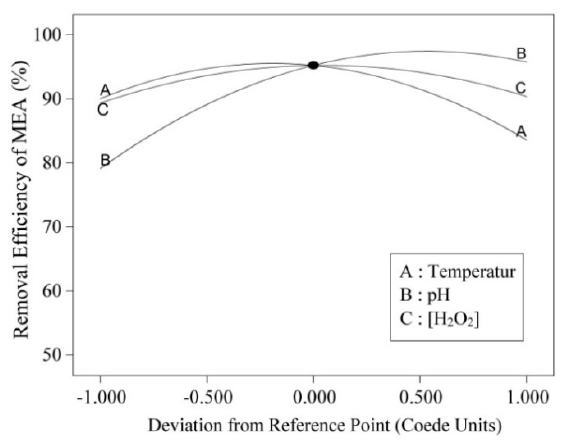
Figure 4. Perturbation plot for the removal e ffi ciency of MEA. A: Temperature; B: pH; C: [H 2 O 2 ]